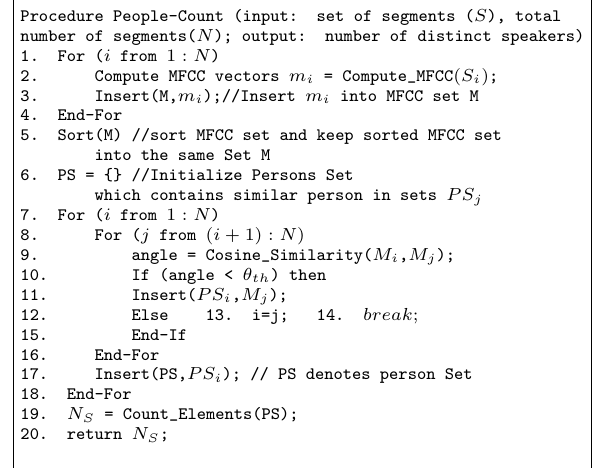
Figure 3: Acoustic People Count Algorithm